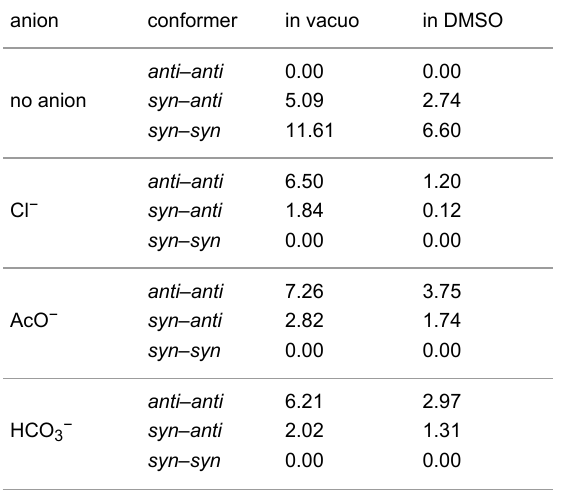
complexes (Table 4). The anti–anti conformers of anion–receptor complexes exhibited considerably higher ener- gies between 6.2 and 7.3 kcal·mol − 1 . The angle between the two indolyl rings in the freely optimized syn – syn conformer of the 1 ·AcO − complex was found to be 21.6° (Figure 6b). The opti- mized structure, shown in Figure 6b, shows a single acetate anion bound to the four NH groups in the receptor 1 with N···O distances in the range from 2.75 to 2.95 Å and N–H···O angles in the range